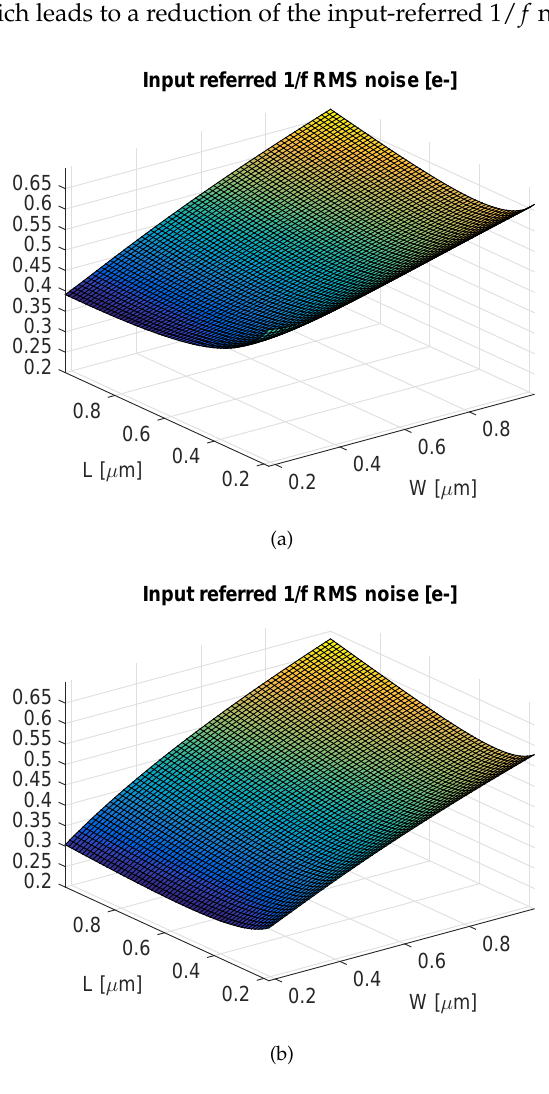
Figure 10. The calculated input-referred 1/ f noise, based on Equation (5), as a function of the in-pixel source follower width W and length L for a thin oxide transistor in a 180-nm technology where C gse = C gde = 0.95 fF/ µ m, C ox = 9.5 fF/ µ m 2 , K = 10 − 11 F 2 V 2 /m 2 , α CMS = 3, and in ( a ) C P = 0.75 fF, it corresponds to the SN capacitance in a standard process, ( b ) C P = 0.25 fF corresponds to an SN capacitance reduced with process-level